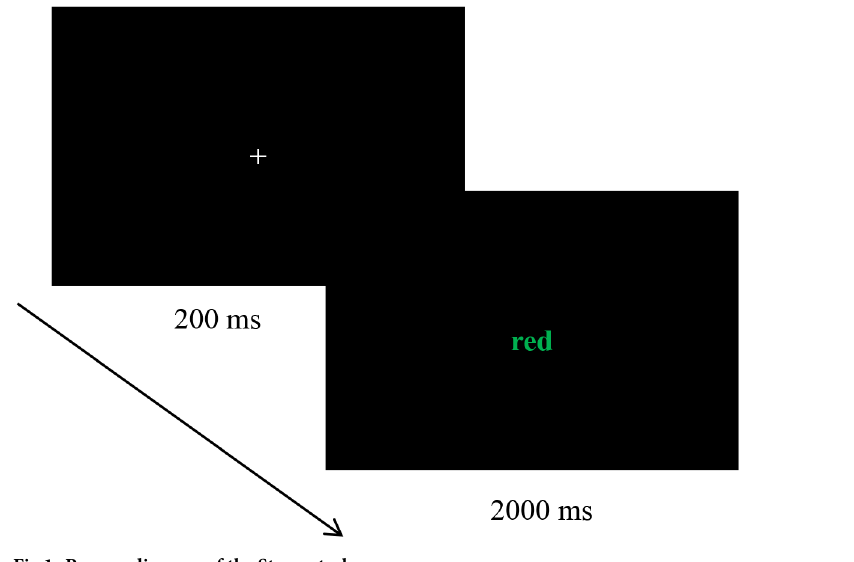
Fig 1. Process diagram of the Stroop task.